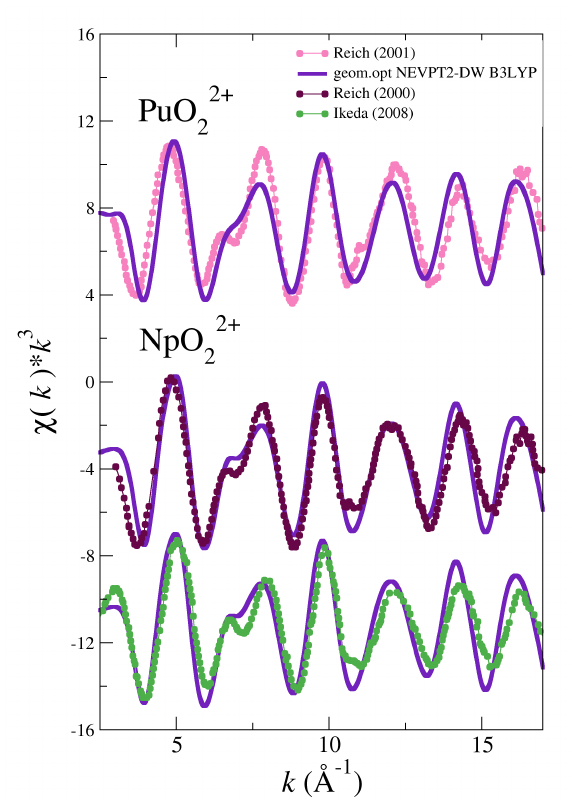
Figure 8. L III -edge k 3 -weighted experimental and simulated EXAFS spectra for PuO 2+ from the NEVPT2 optimized geometries for their pentahydrates and using the DW factors of their corresponding MD simulations using the B3LYP force